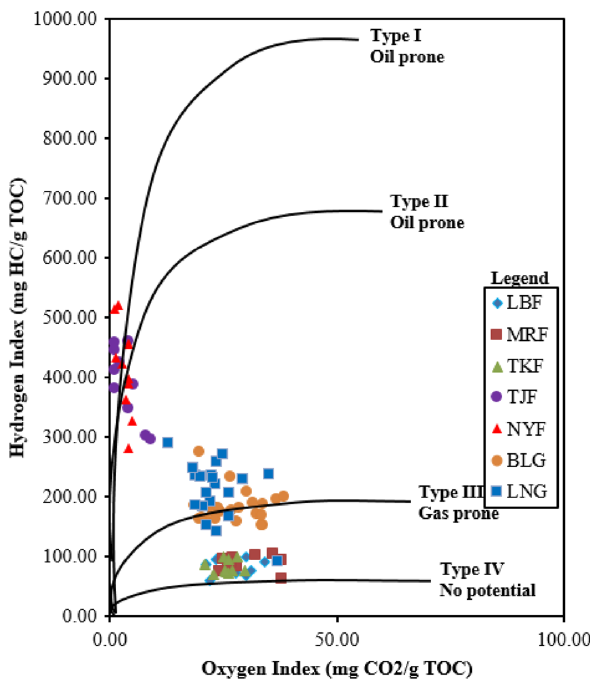
Fig. 10 Plot of hydrogen index against oxygen index for possible source rocks samples ( n = 95) representing LBF Lambir, MRF Miri, TKF Tukau, TJF Tanjong, NYF Nyalau, BLG Balingian and LNG Liang formations. Note the concentration of TJF and NYF points around Types I and II kerogen curves. The MRF, TKF, and LBF points sandwiched between Type III and IV Plotted data were sourced from Hakimi and Abdullah (2013), Hakimi et al. (2013a, b); Togunwa et al.